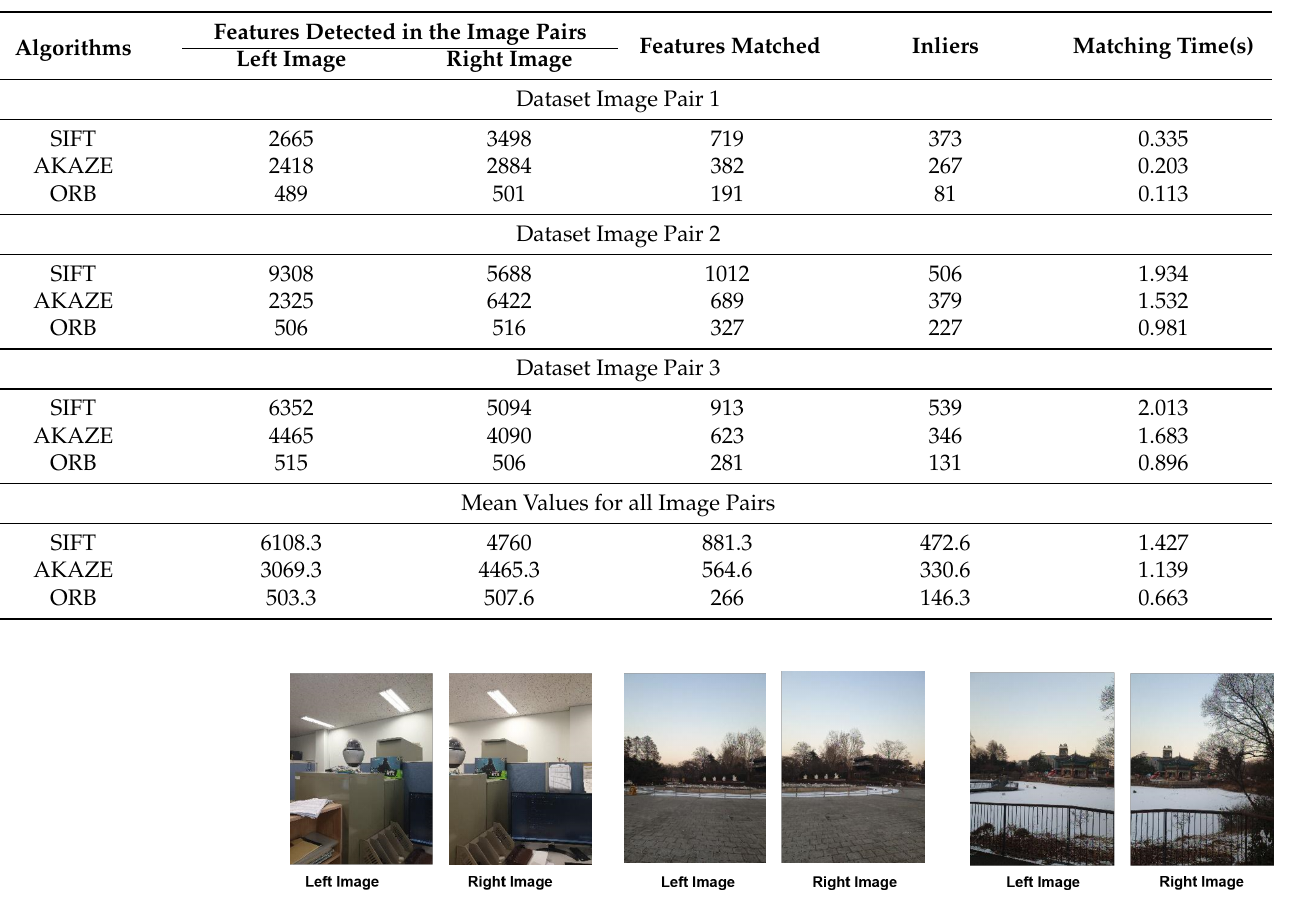
Table 3. Quantitative comparison and performance costs of the given feature-detector descriptor.